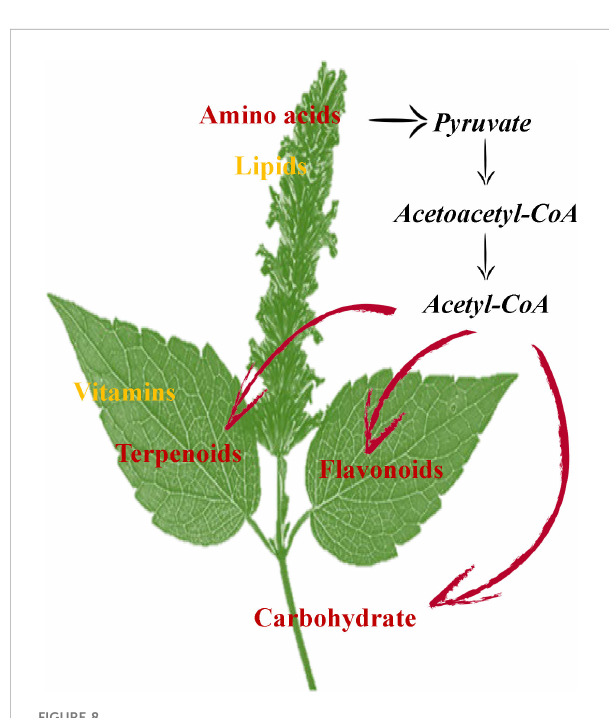
FIGURE 8 The possible mechanisms for the synthesis and accumulation of compounds in the leaves, stems and fl owers of P. cablin . Flowers contain high levels of amino acids and lipids. Leaves contain high levels of terpenoids and fl avonoids. Stems contain high levels of